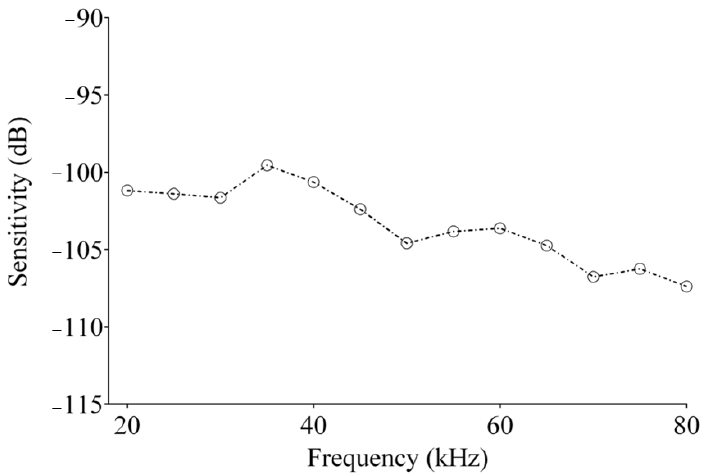
Figure 11. Receiver sensitivity evaluated through the VCII-based interface in the range of 20–80 kHz (10 V/Pa as 0 dB scale) on the horizontal plane with the transmitter and the received placed face-to-face.